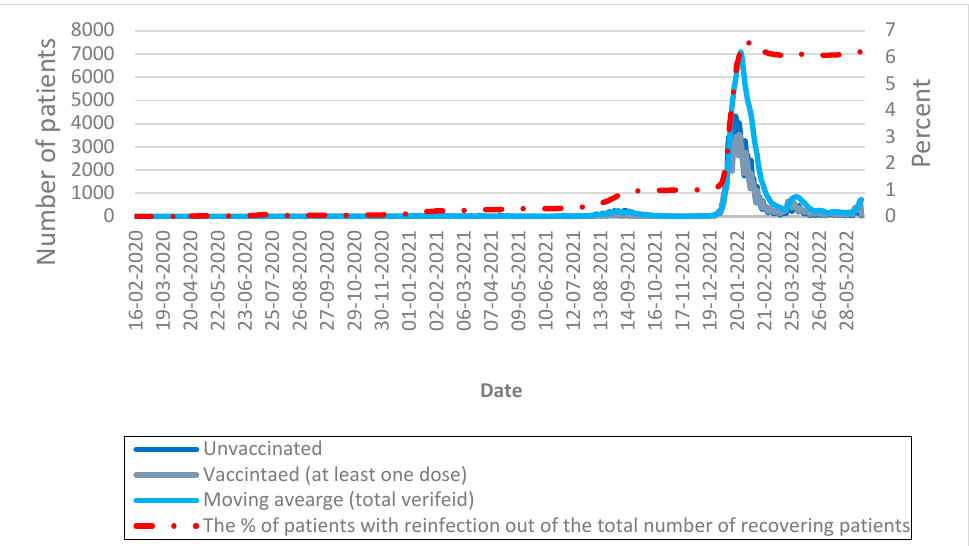
Figure 4. Percentage of positive patients per age group after X (denoted in legend) days after vac- cination dose (( a ): first dose; ( b ): second dose; ( c ): third dose). Figure 5, which indicates re-infection, shows that from the beginning of the epidemic until now, the re-infection rate is about 6.22% of all recoverees. This rate is significantly higher among those who are not vaccinated compared to those who have been vaccinated, at least in one dose.